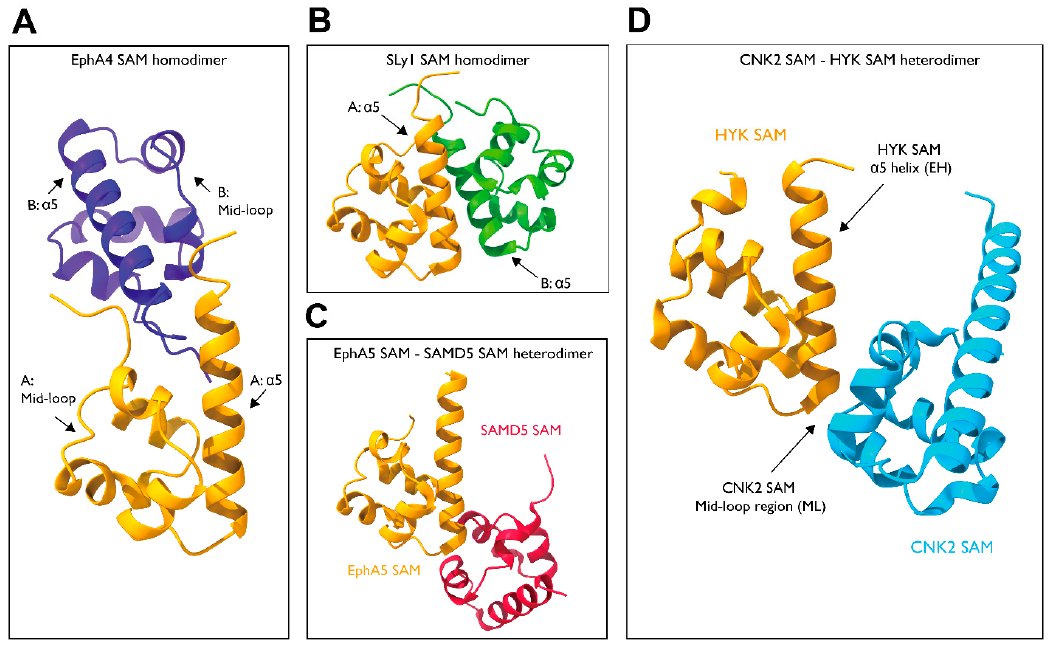
Figure 7. Structure of the SAM–SAM dimers. ( A ) EphA4-SAM homodimer (PDB: 1B0X). ( B ) SLy1-SAM homodimer (PDB: 6G8O). ( C ) EphA5-SAMD5 dimer (PDB: 5ZRZ). ( D ) CNK2-HYP dimer (PDB: 3BS5).